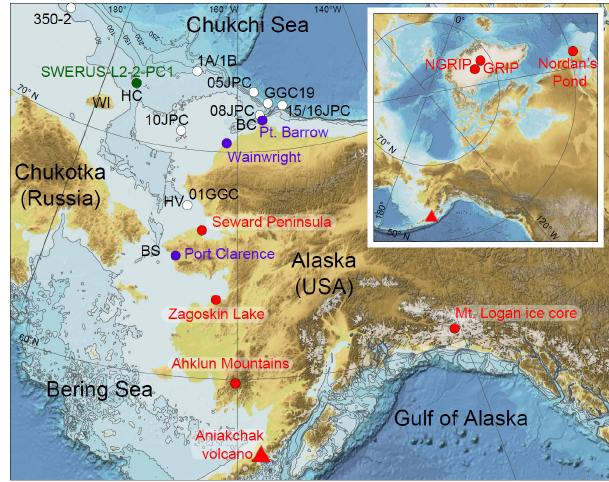
Figure 1. Map of study area and all sites mentioned in this study. Colors of markers – red: sites with Aniakchak CFE II tephra; blue: sites with modern (cid:49)R data; white: marine sediment cores men- tioned in the discussion; green: Core 2PC, subject of this study. Full core names with prefix in parentheses and references for site loca- tions: (HLY0501-) 5JPC, (HLY0205-) 16JPC, (HLY0501-) 08JPC (Darby et al. 2009), (ARA2B-) 1A/1B, (PS272/) 350-2 (Stein et al., 2017), and (HLY0204-) 10JPC, (HLY0204-) 01GGC/02JPC, (HLY0205-) GGC19 (Keigwin et al., 2006). Other abbreviations: HC (Herald Canyon), WI (Wrangel Island), BC (Barrow Canyon), HV (Hope Valley), and BS (Bering Strait). Ocean bathymetry and land topography are from the General Bathymetric Chart of the Oceans, GEBCO (Weatherall et al., 2015), and the International Bathymetric Chart of the Arctic Ocean, IBCAO (Jakobsson et al.,